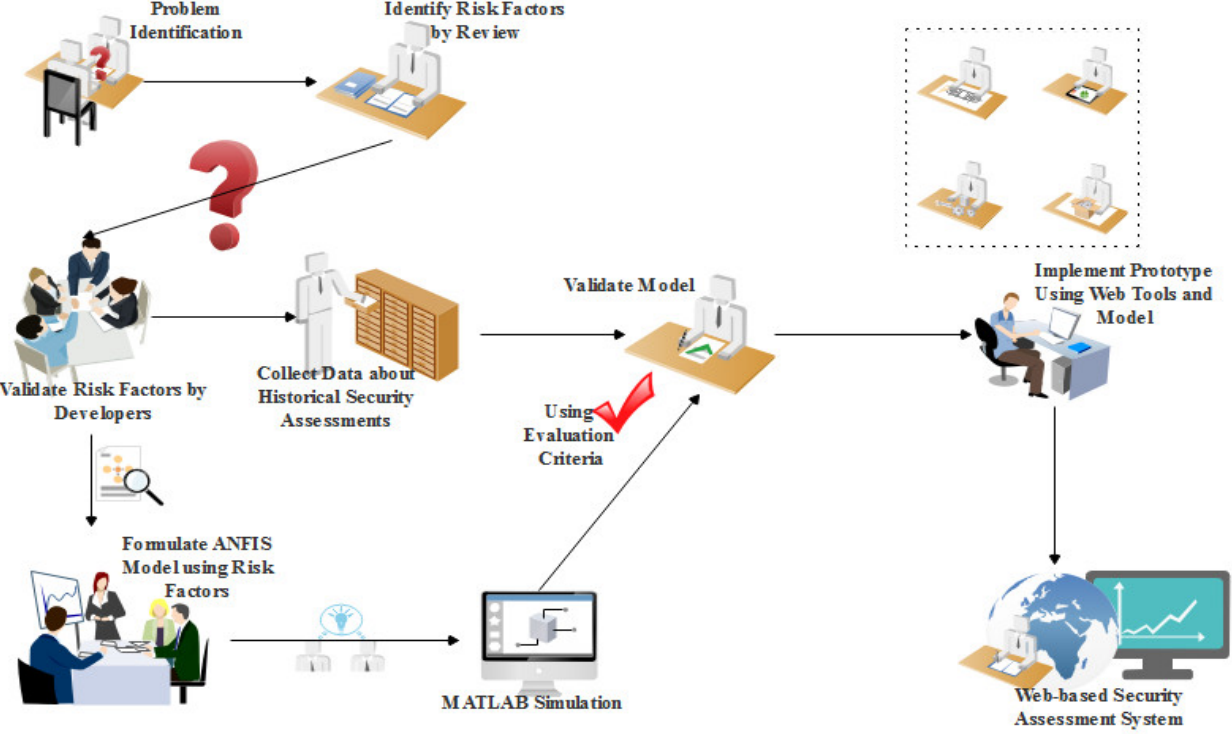
Figure 1. Conceptual view of research methodology process.